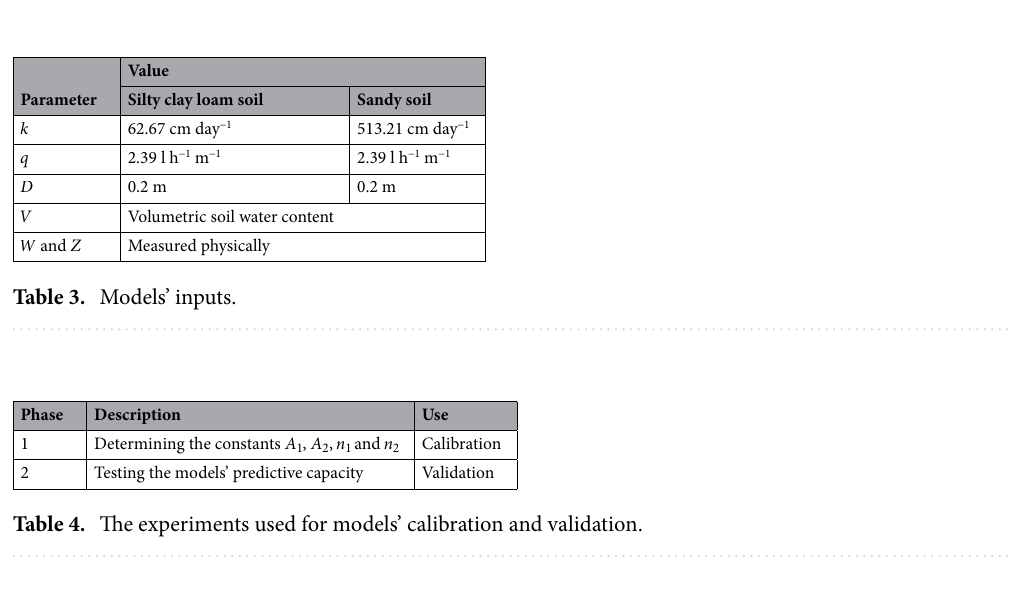
Table 2. MPS-2 sensors placement depths and lateral spacing for the respective soils.